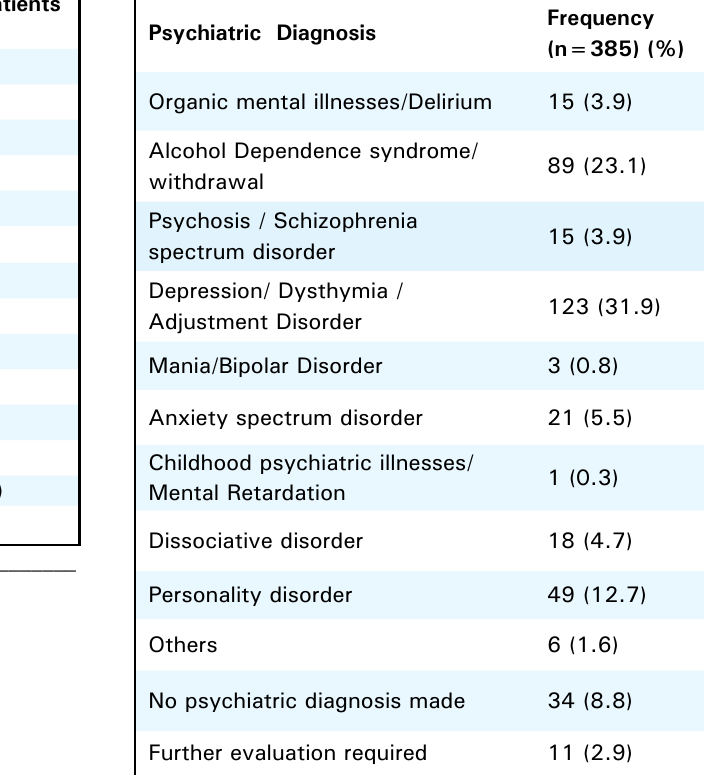
Table 5. Psychiatric Diagnoses of the Patients